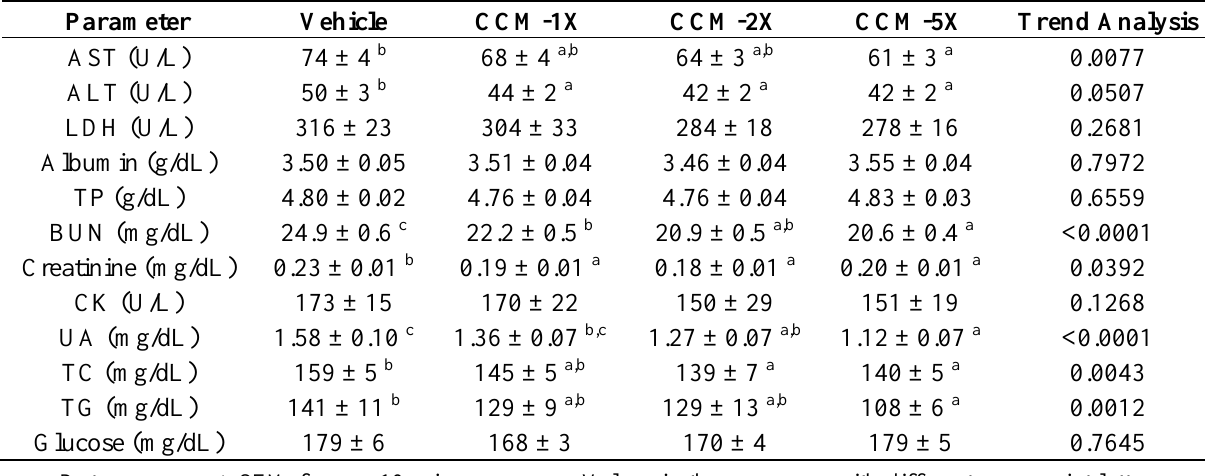
Data are mean ± SEM for n = 10 mice per group. Values in the same row with different superscript letters